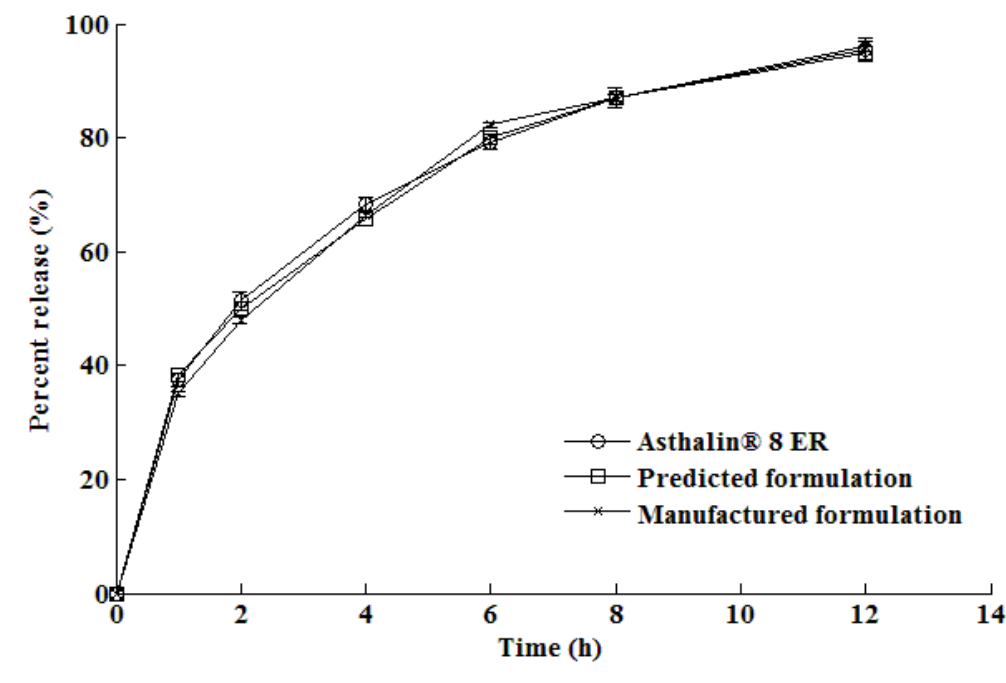
Figure 6. In vitro release profile of the optimized formulation compared with the reference formulation, Asthalin ® 8 ER.